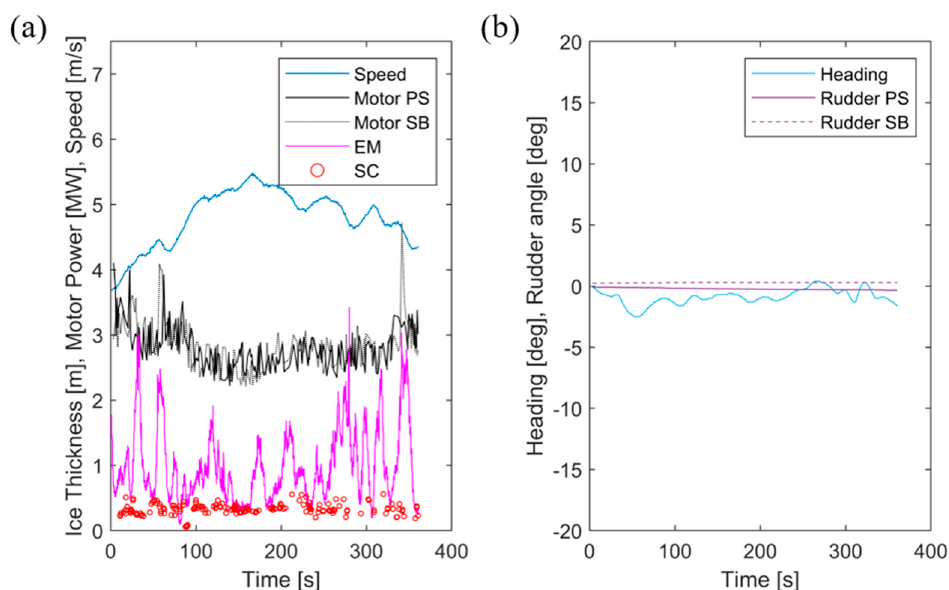
Figure 6. ( a ) Applied motor power, measured ice thickness with the electromagnetic device (EM) and stereo camera system (SC), and obtained speed, and ( b ) applied rudder angles with obtained heading during test L1.